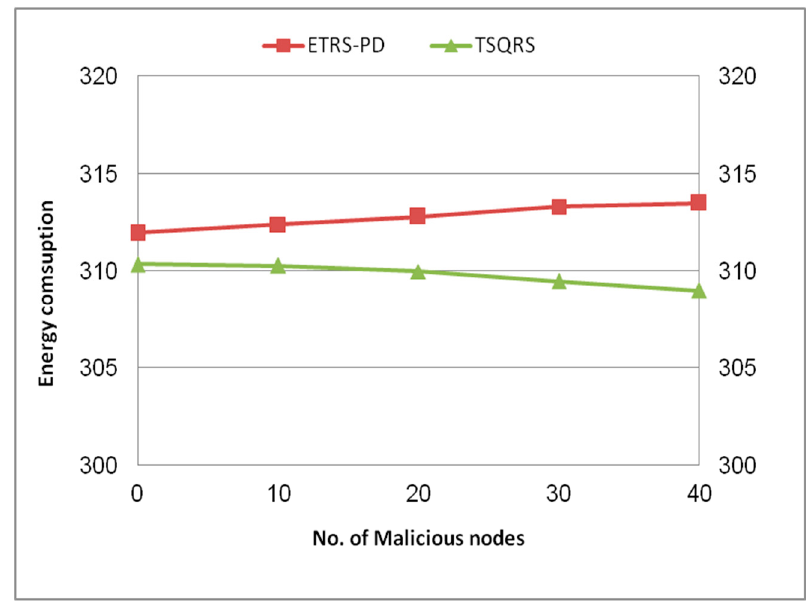
Figure 10. EC against percentage of malicious nodes.